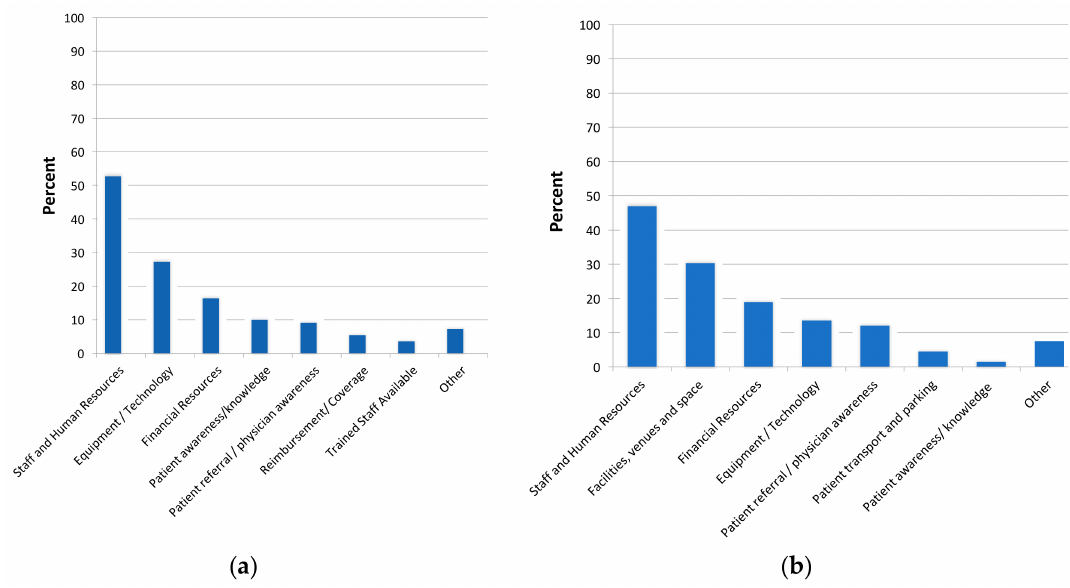
Figure 3. Needed elements to increase capacity of alternative model delivery. ( a ) home-based; ( b )